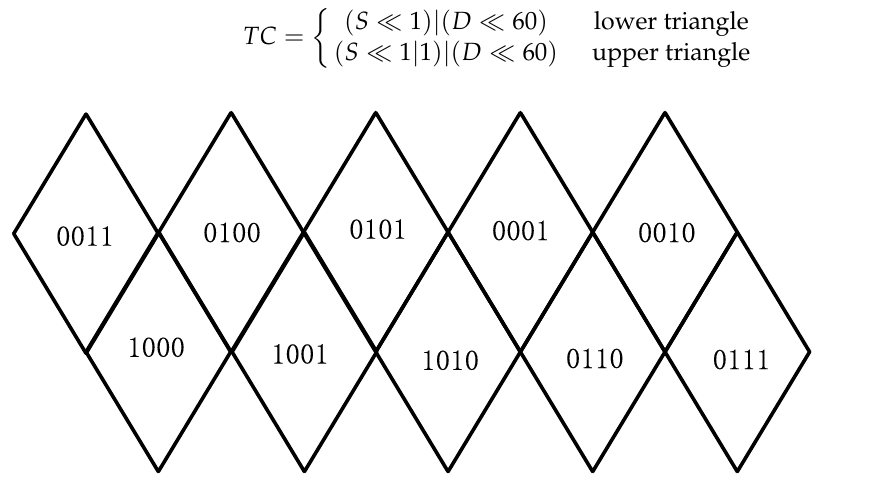
( c ) Figure 3. Different spherical grids. ( a ) diamond grid; ( b ) triangular grid; and ( c ) hexagonal grid. 2.2. Filling Curve of Spherical Grid On the basis of quadtree subdivision, the Hilbert curve and Z-curve space indexes of the spherical diamond, triangular and hexagonal grids are established, respectively. The core coding rule is the combination of the basic diamond code and spatial filling curve